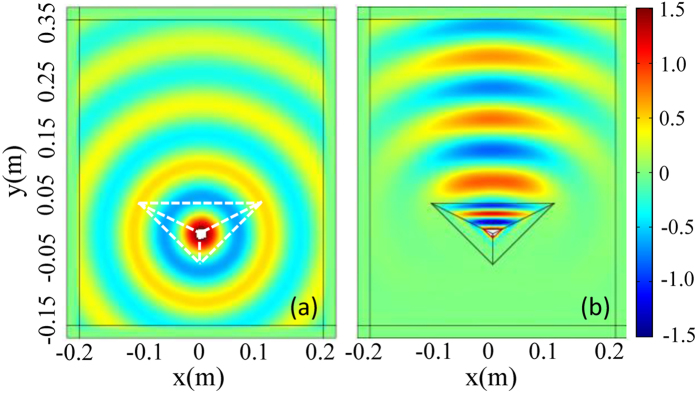
The electric field distribution of a point source embedded in free space (a) and transformation medium (b), respectively. The corresponding coordinates in this case are: O’(0, 0), A(0, −0.05 m), B(−0.1 m, 0.05 m), C(0.1 m, 0.05 m), O(0, 0), A1(−0.01 m, 0.02 m), B1(0, 0.02 m); C1(0.01 m, 0.02 m), B2(−0.1 m, 0.2 m), C2(0.1 m, 0.2 m).